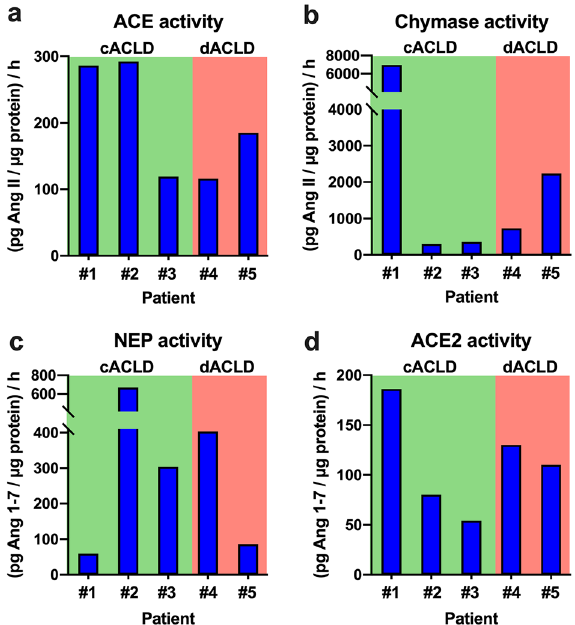
Figure 3. Tissue activity of components of the ( a , b ) classical (ACE, chymase) and ( c , d ) alternative RAS (neprilysin [NEP], ACE2) in 5 patients with compensated (cACLD; n = 3) and decompensated advanced chronic liver disease (dACLD; n = 2). ACE angiotensin converting enzyme, cACLD compensated advanced chronic liver disease, dACLD decompensated advanced chronic liver disease, NEP neprilysin, RAS renin–angiotensin